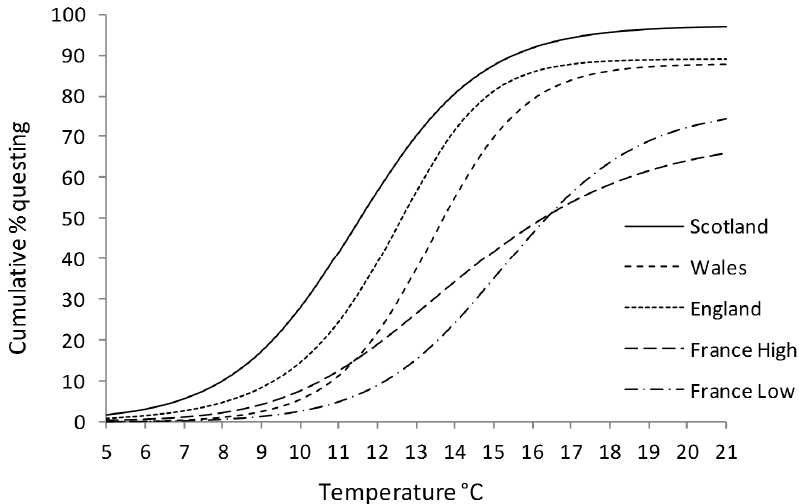
Figure 3. Curves fitted to the predicted values from the Richards equation, for the cumulative % of I.ricinus in each population to initiate questing over the course of the hourly temperature increase